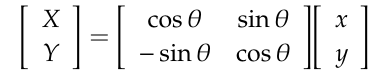
Figure 4; black lines, Figure 5) to write the quasiperiodic Fourier series for the equation. Sequel papers will extend these boundaries to higher order and construct their quasiperiodic Fourier series.